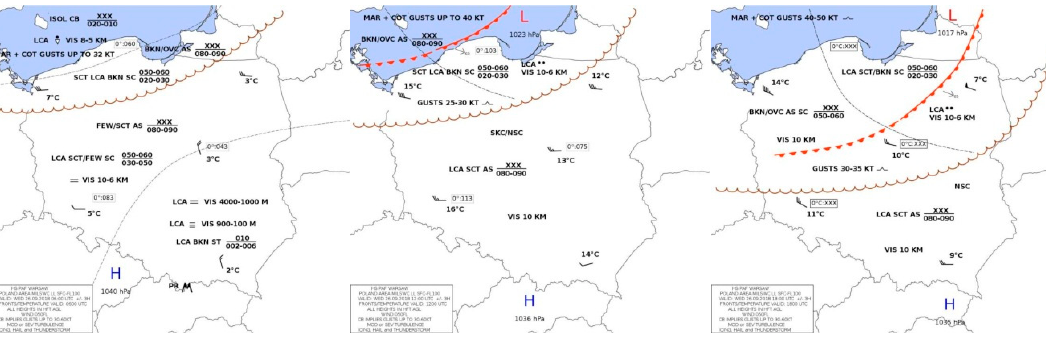
Figure 10. Graphical forecast for Poland for September 26, 2018, at 06:00, 12:00, and 18:00 UTC ( ± 3 h) (based on Reference [43]).